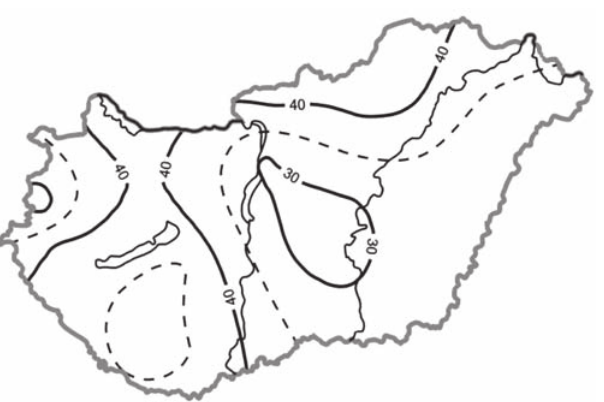
Figure 4 – The absolute daily maxima of precipitation in winter over 16 meteorological stations during the period of 1951–2010